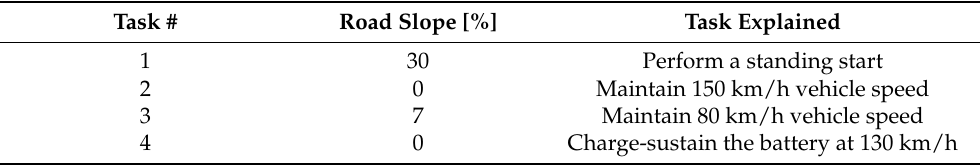
Table 3. Task required to be completed by the HEV in the drivability